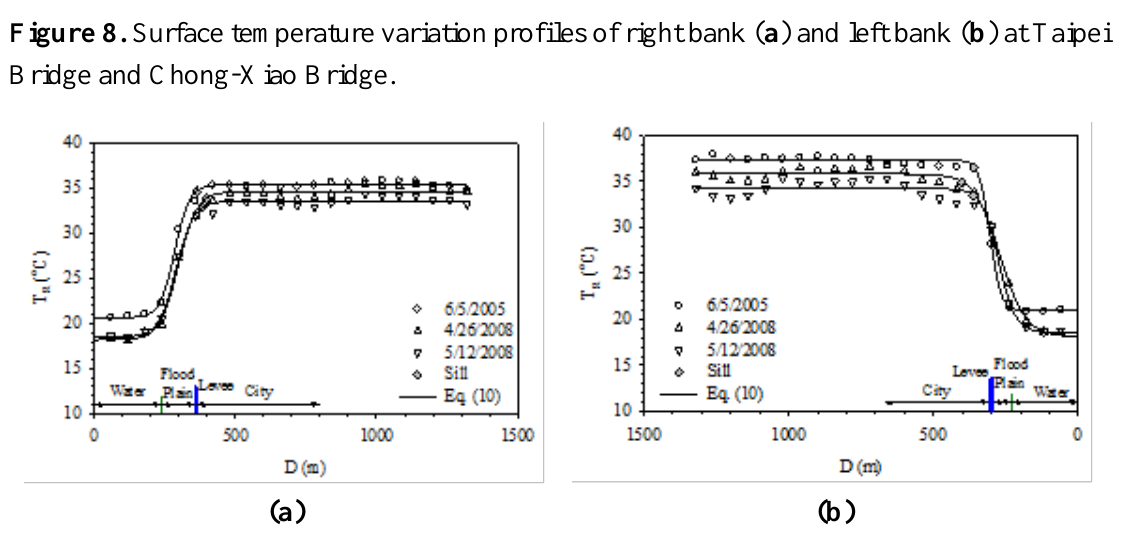
Figure 9. Surface temperature variation at Chong-Yang Bridge